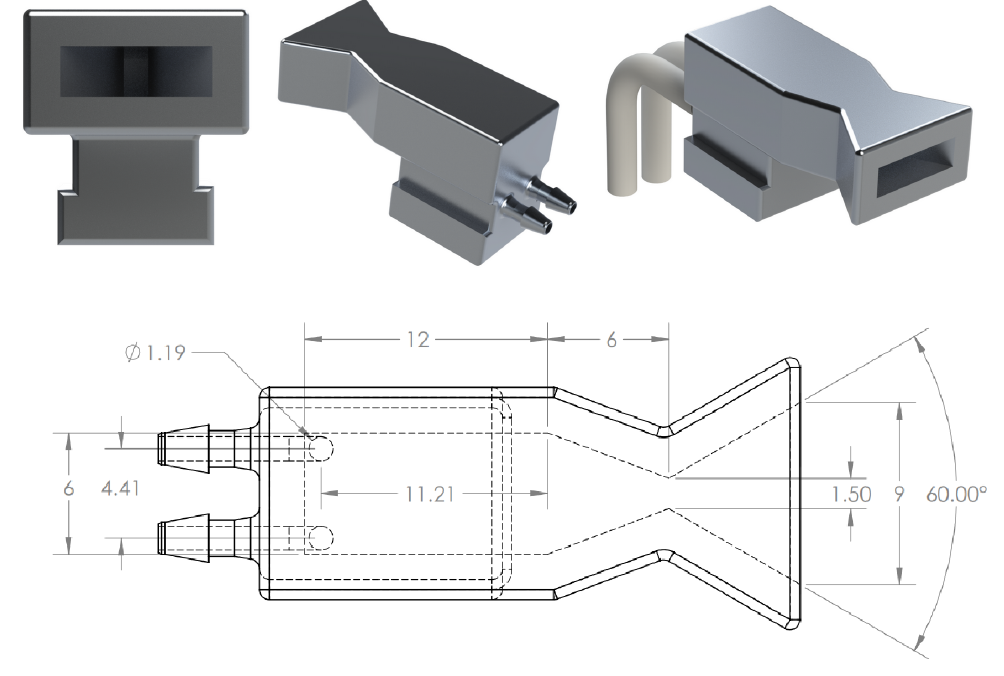
Figure 7. Schematic of the 50 mN attitude control thruster. Dimensions are in mm.